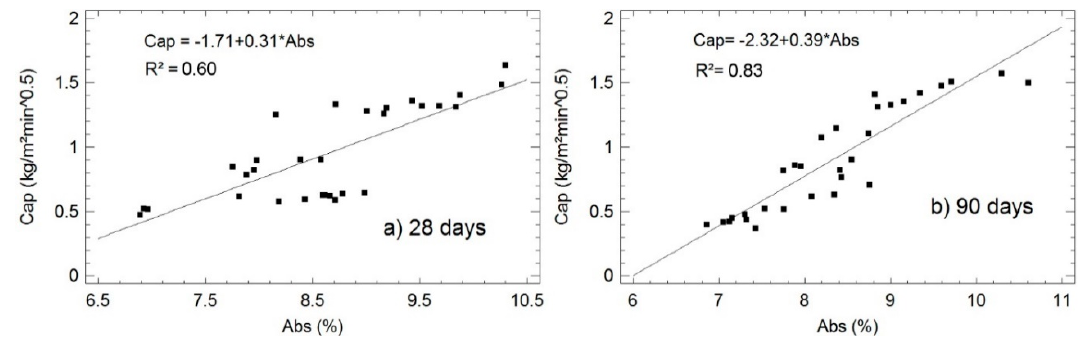
Figure 5. Adjusted models of the relationship between Cap and Abs in specimens cured for 28 ( a ) and 90 days ( b ).